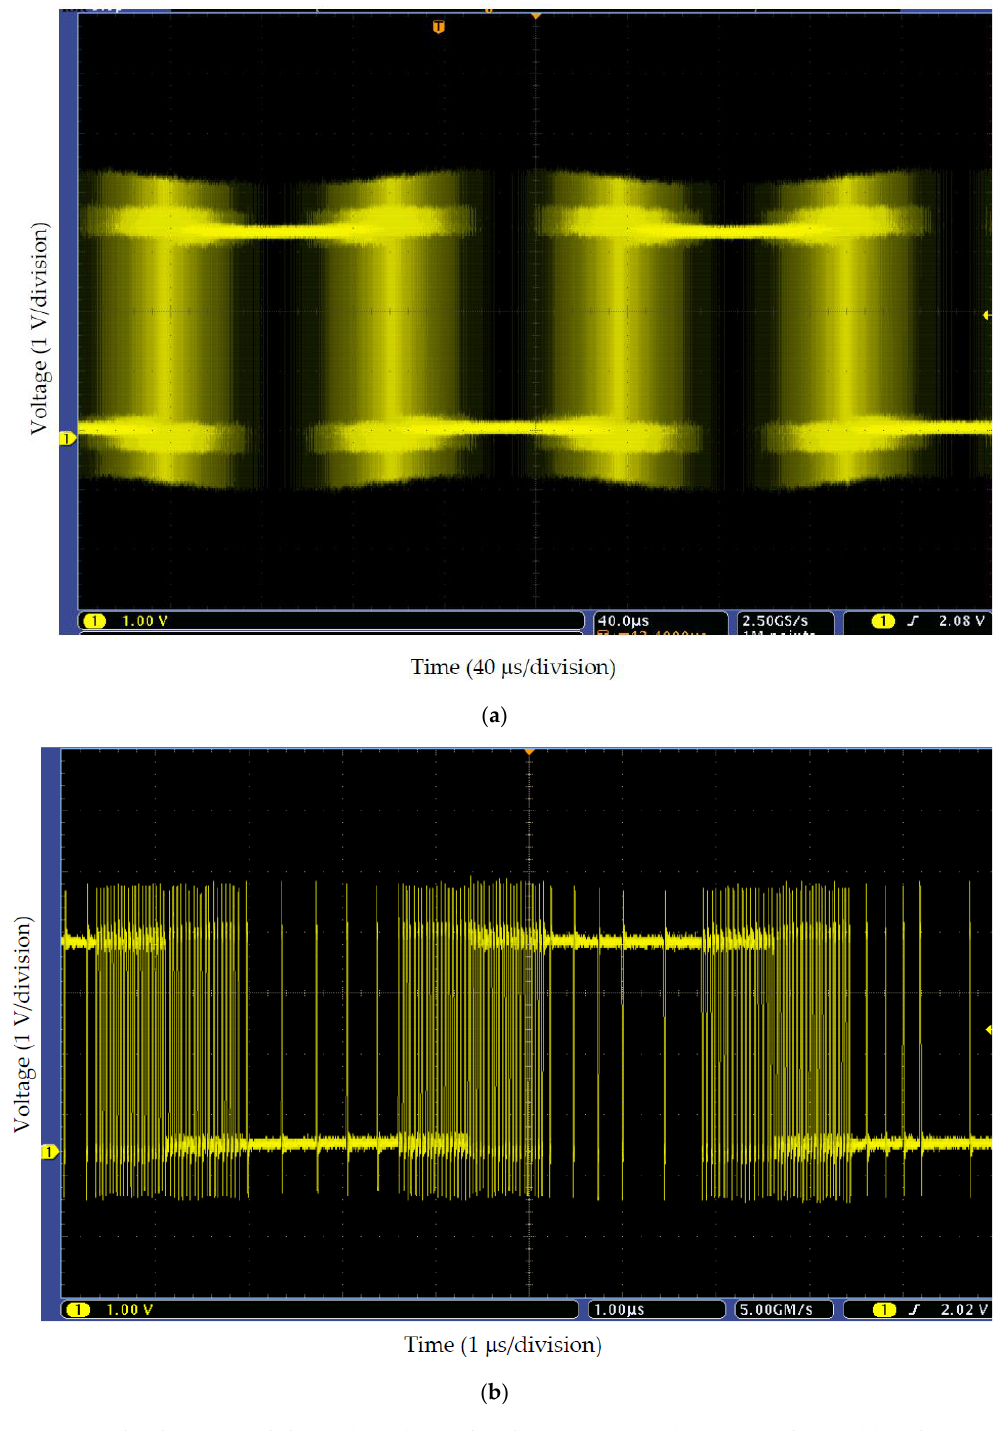
Figure 4. Pulse density modulation (PDM) signal (voltage versus time) corresponding to ( a ) a 5 kHz and ( b ) 150 kHz sinusoidal outputs. The 80 MHz pulse density is maximum for the rising and falling slopes of the sinusoidal signal and it is minimum for the maximum and minimum sinusoidal signal